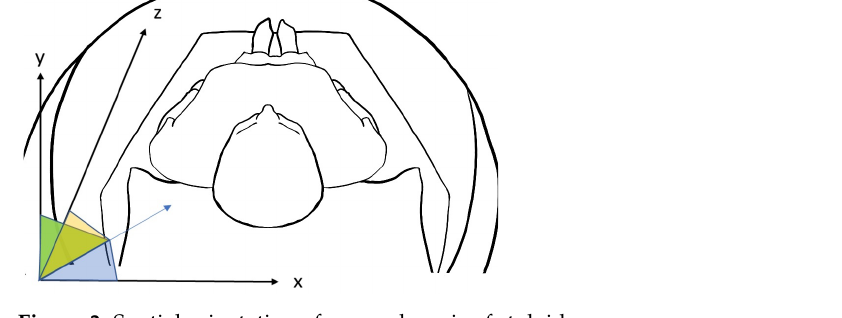
Table 2. Characteristics of the sample, overall and by Eagle syndrome status. Variables